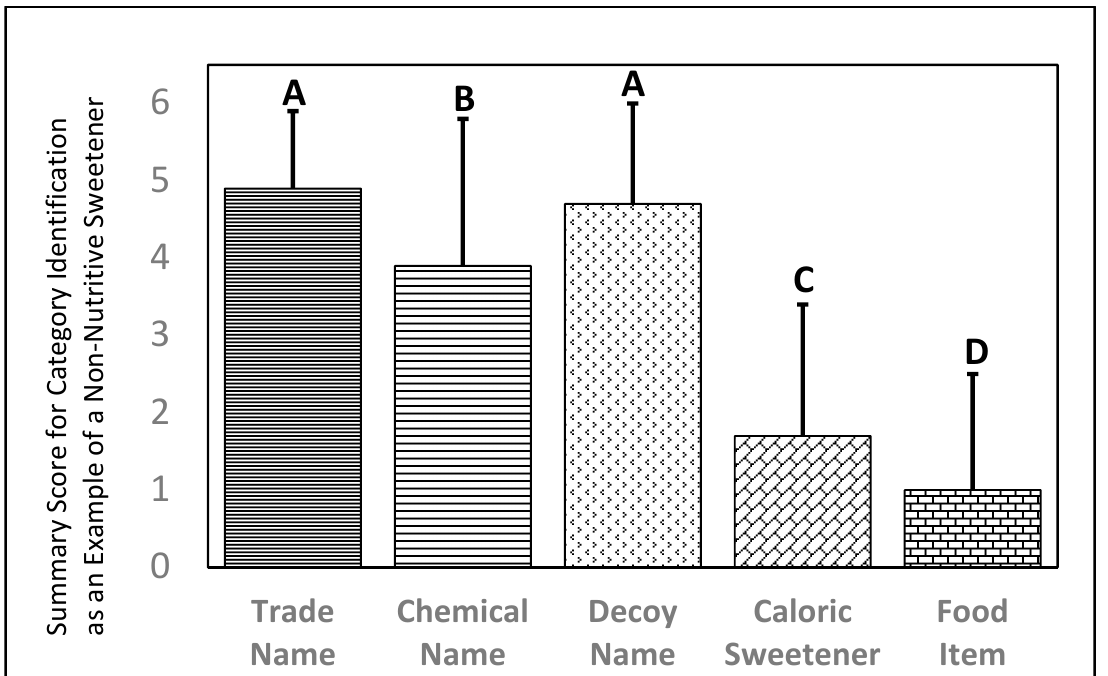
Figure 3. Respondent ability to sort items within different categories as being examples of non-nutritive (artificial) sweeteners (NNS) with a click-drag-box tool. Mean ± SD with statistical significance between groups indicated by differing column letters using Tukey’s HSD ( p < 0.05).